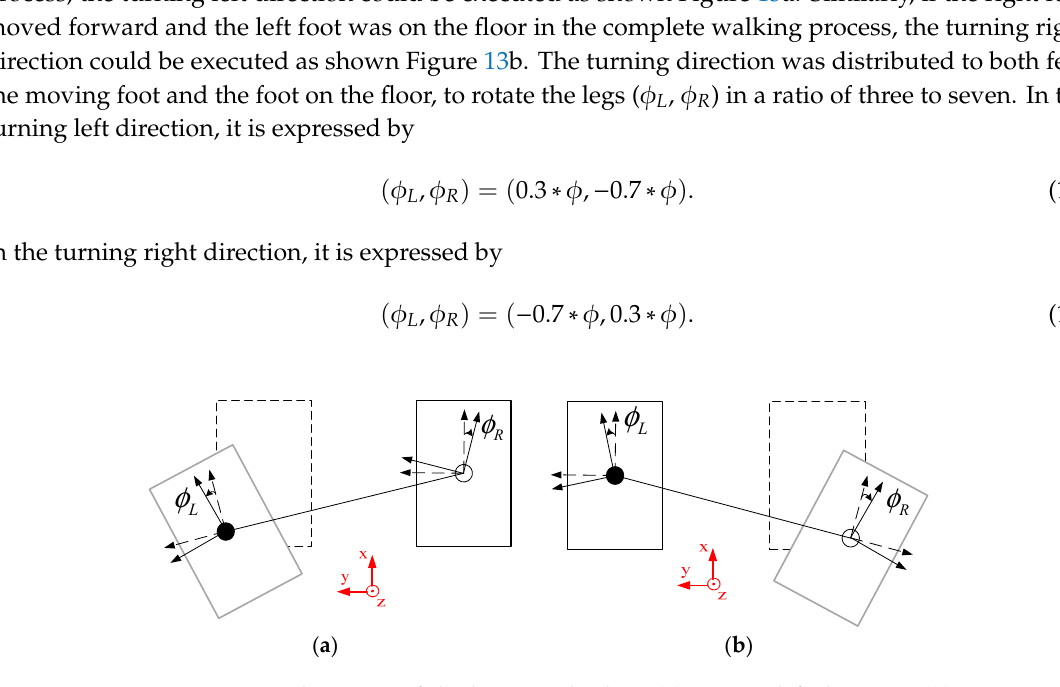
Figure 12. A complete walking process showing the three modes and six phases: ( a ) horizontal plane; ( b ) sagittal plane; ( c ) frontal plane.